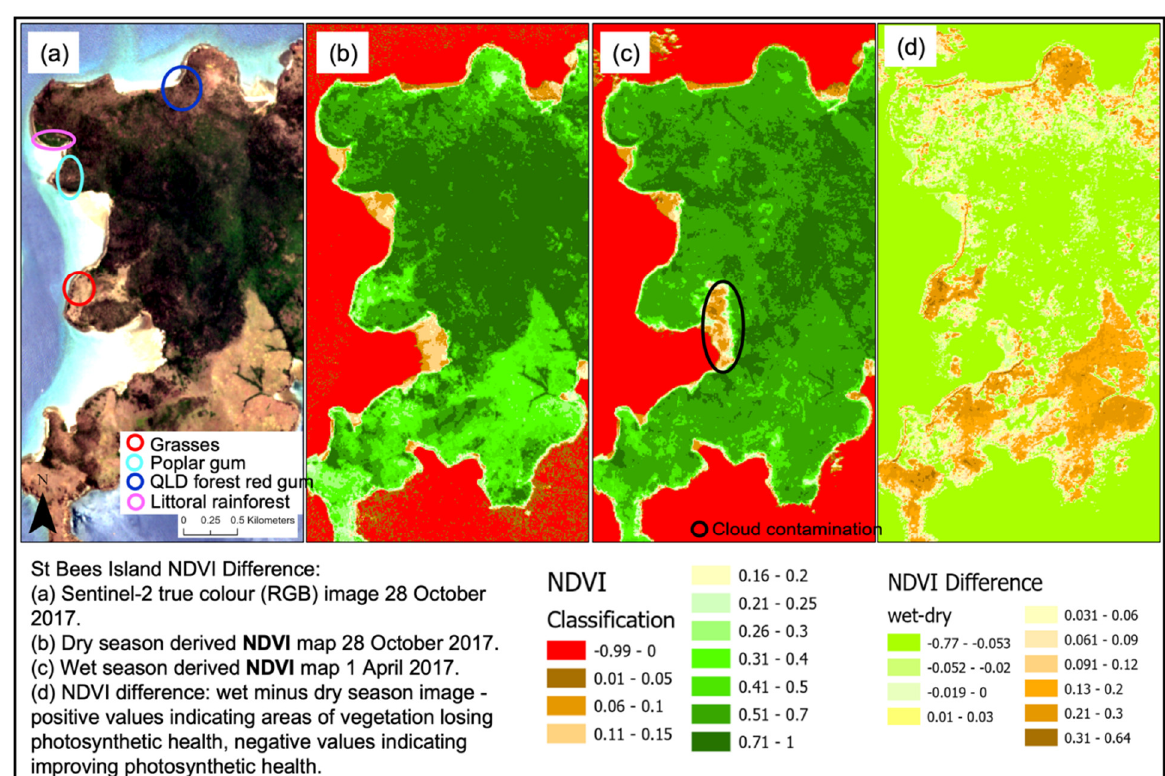
Figure A10. St Bees Island NDVI Difference.